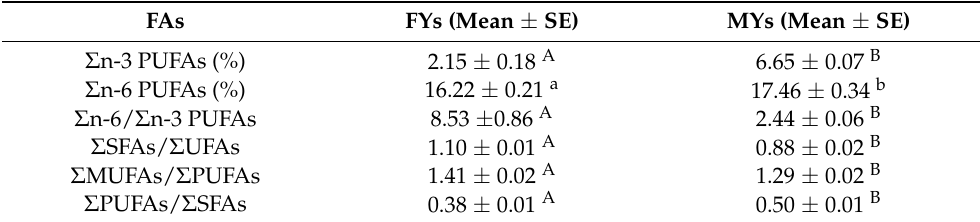
Table 3. The relative contents of Σ n-3 and Σ n-6 polyunsaturated fatty acids (PUFAs) and the ratio of different types of FAs in LD of FYs and MYs.